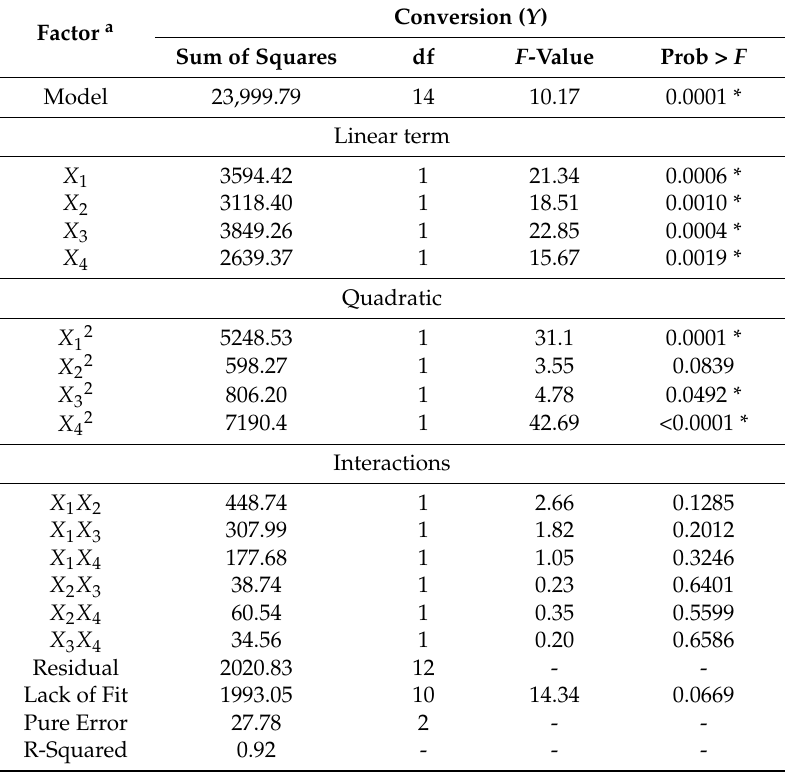
Table 2. ANOVA for response surface models of all independent variables. Conversion ( Y ) Factor a Sum of Squares df F -Value Prob > F Model